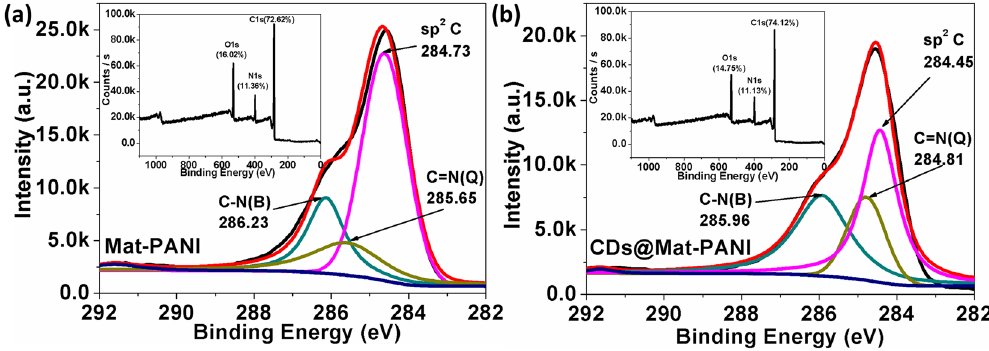
Figure 4. XPS C1s core-level spectra of ( a ) Mat-PANI and ( b ) CDs@Mat-PANI. The insets show general XPS spectra of Mat-PANI and